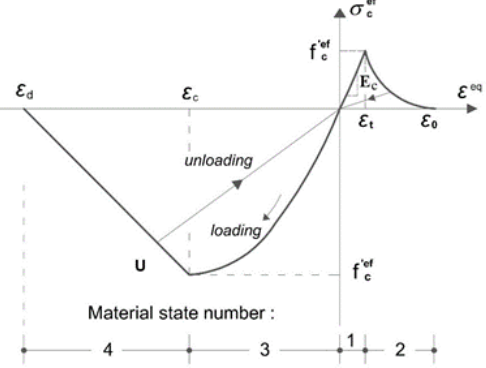
Figure 3. Equivalent uniaxial stress-strain of concrete.